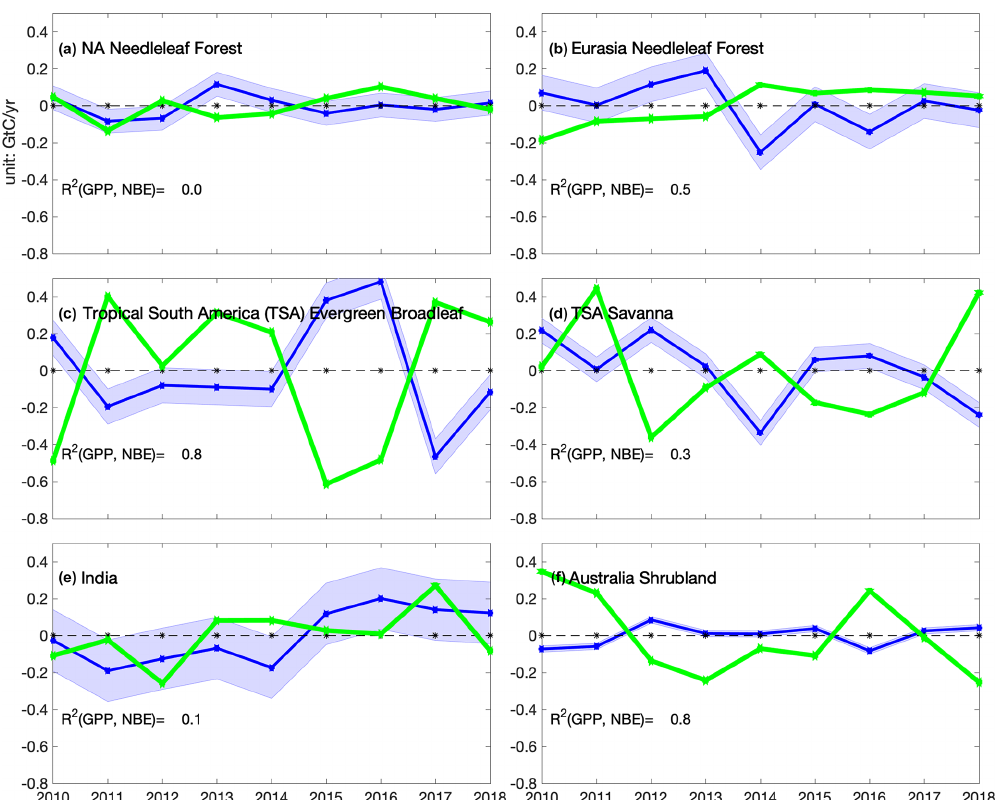
Figure 7. The NBE interannual variability over six selected regions. Blue: annual NBE anomaly and its uncertainties. Green: annual GPP anomaly based on